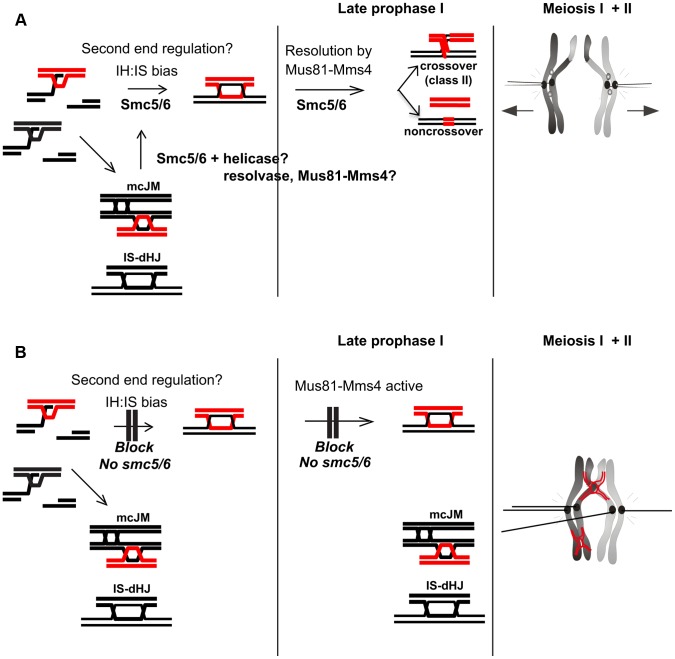
Model for Smc5/6 function during meiosis.(A) In wild type cells, Smc5/6 is present and ensures the formation of IH-dHJs either directly or perhaps by removing mcJMs and IS-dHJs, returning them to an interhomolog fate. This could be done in co-operation with helicases and resolvases, potentially Mus81-Mms4. (B) In the absence of Smc5/6, second end regulation is aberrant and cells enter late prophase with increased mcJMs and IS-dHJs. These are not cleaved by Mus81-Mms4, which is hyperphosphorylated by Cdc5, because it requires Smc5/6. Since the joint molecules do not appear to trigger a prophase I checkpoint, smc5/6 mutants enter the nuclear divisions with joint molecules as well as precociously separated sister kinetochores that prevent chromosome segregation, leading to meiotic catastrophe.